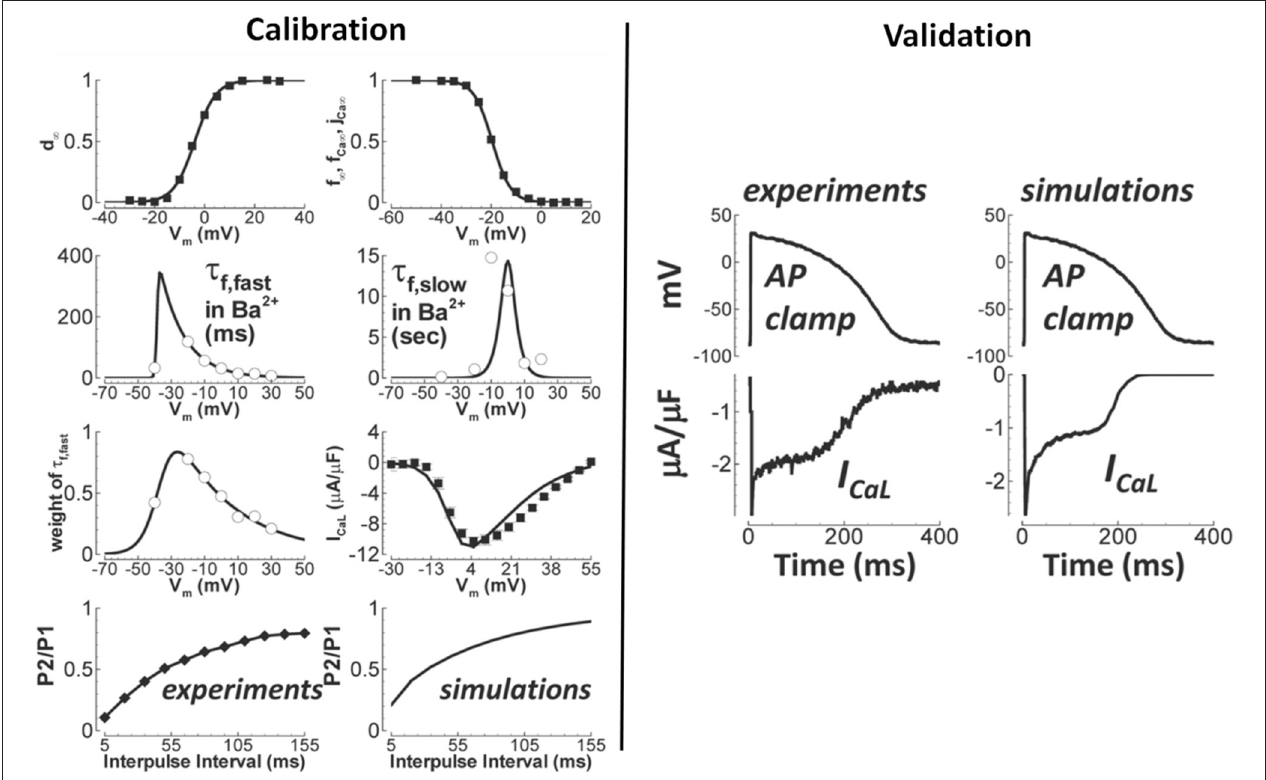
FIGURE 3 | Calibration and validation of the L-type Ca 2 + current of O’Hara et al. (2011). Left figures show calibration results (circles/squares/diamonds—experiment; solid lines—simulation), including fitting of steady-state activation and inactivation (top row) and time constants (second row). Right figures are qualitative validation of the formulated I CaL model by comparison of simulation and experiment under an identical action potential clamp. Quantitative validation of peak current is also provided in original paper. (Adapted from Figure 1 of O’Hara et al. (2011) with permission under Creative Commons